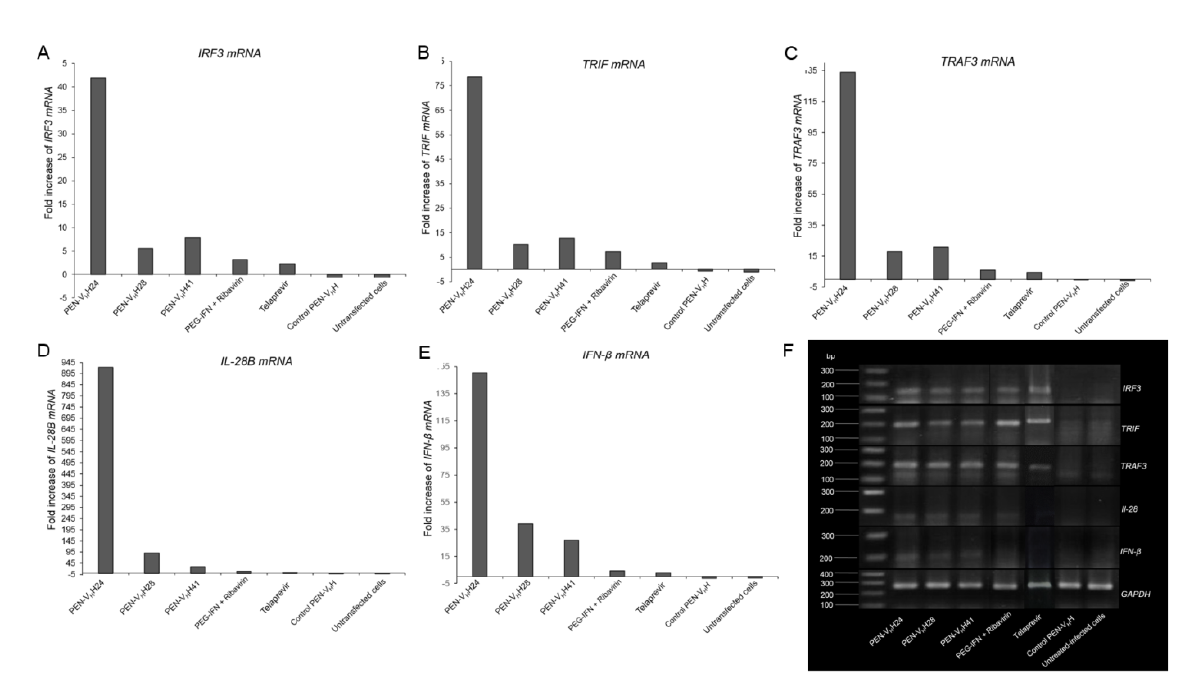
Figure 8. Expressions of innate immune response genes including IRF-3 , TRIF , TRAF-3 , IL-28B and IFN- β of the JFH-1 RNA transfected human hepatic (Huh7) cells that